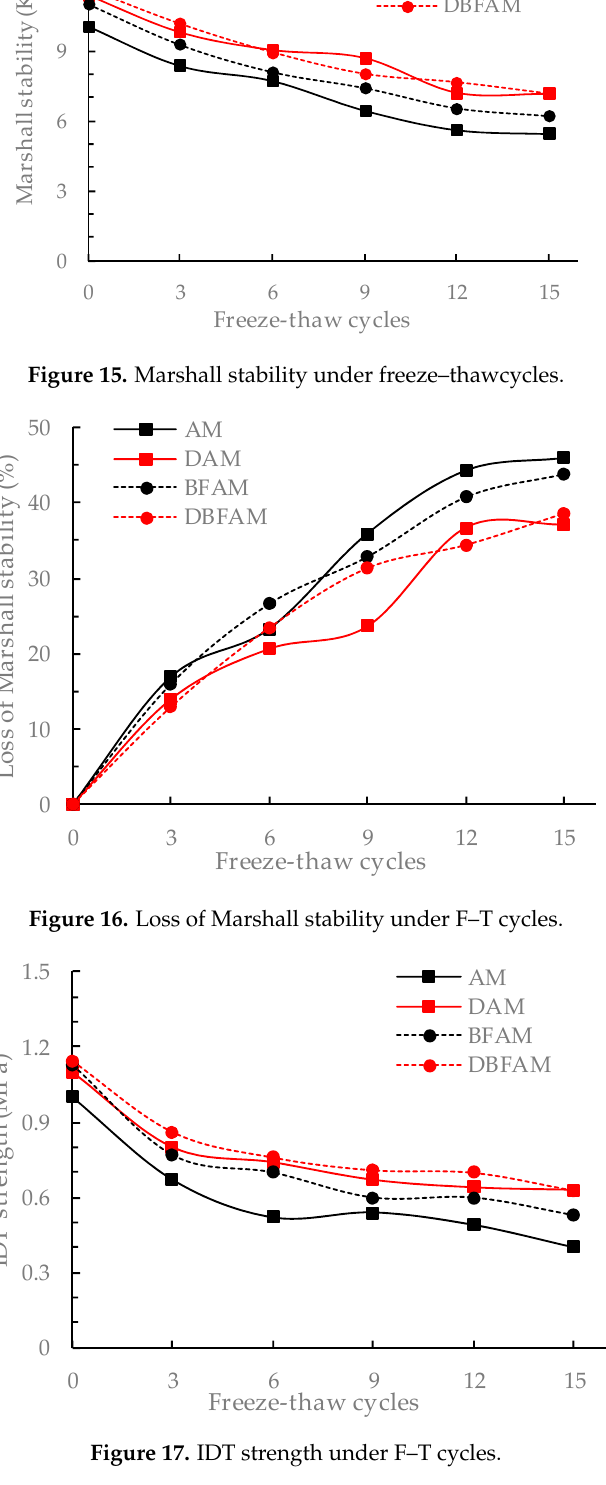
Figure 18. Loss of IDT strength under F–T cycles.